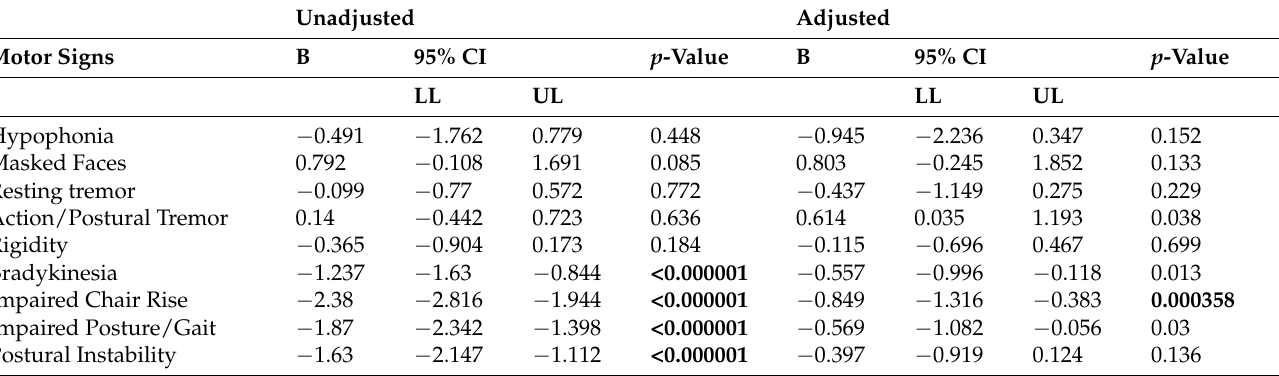
Table 5. Linear regression analysis for association between motor signs and semantic